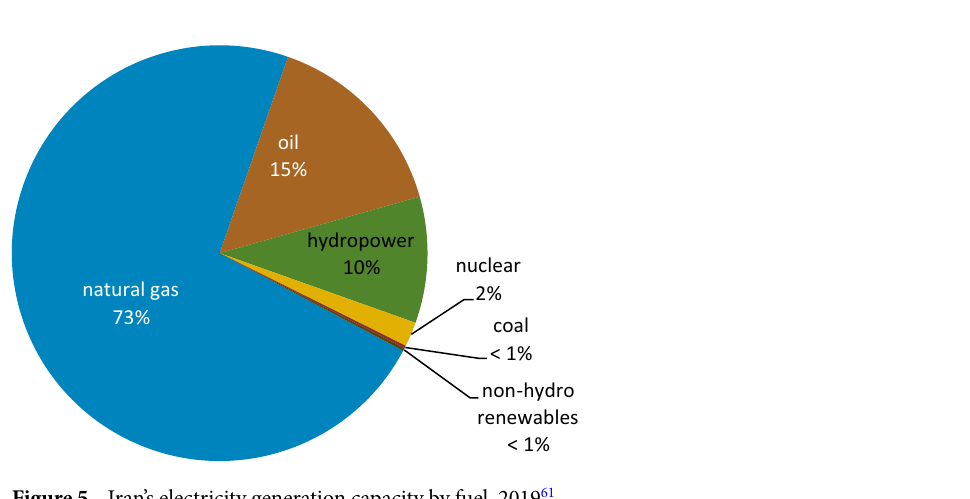
Figure 5. Iran’s electricity generation capacity by fuel, 2019 61